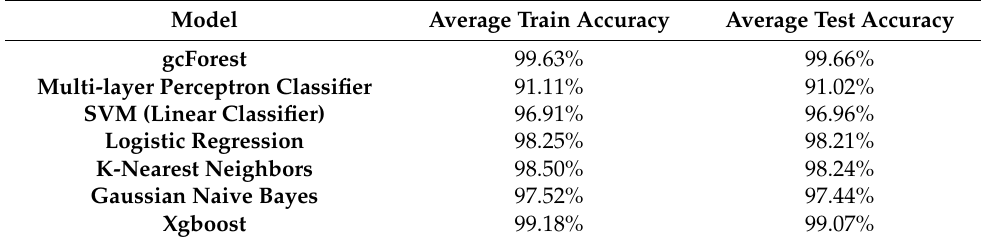
Table 13. Average FAR of different